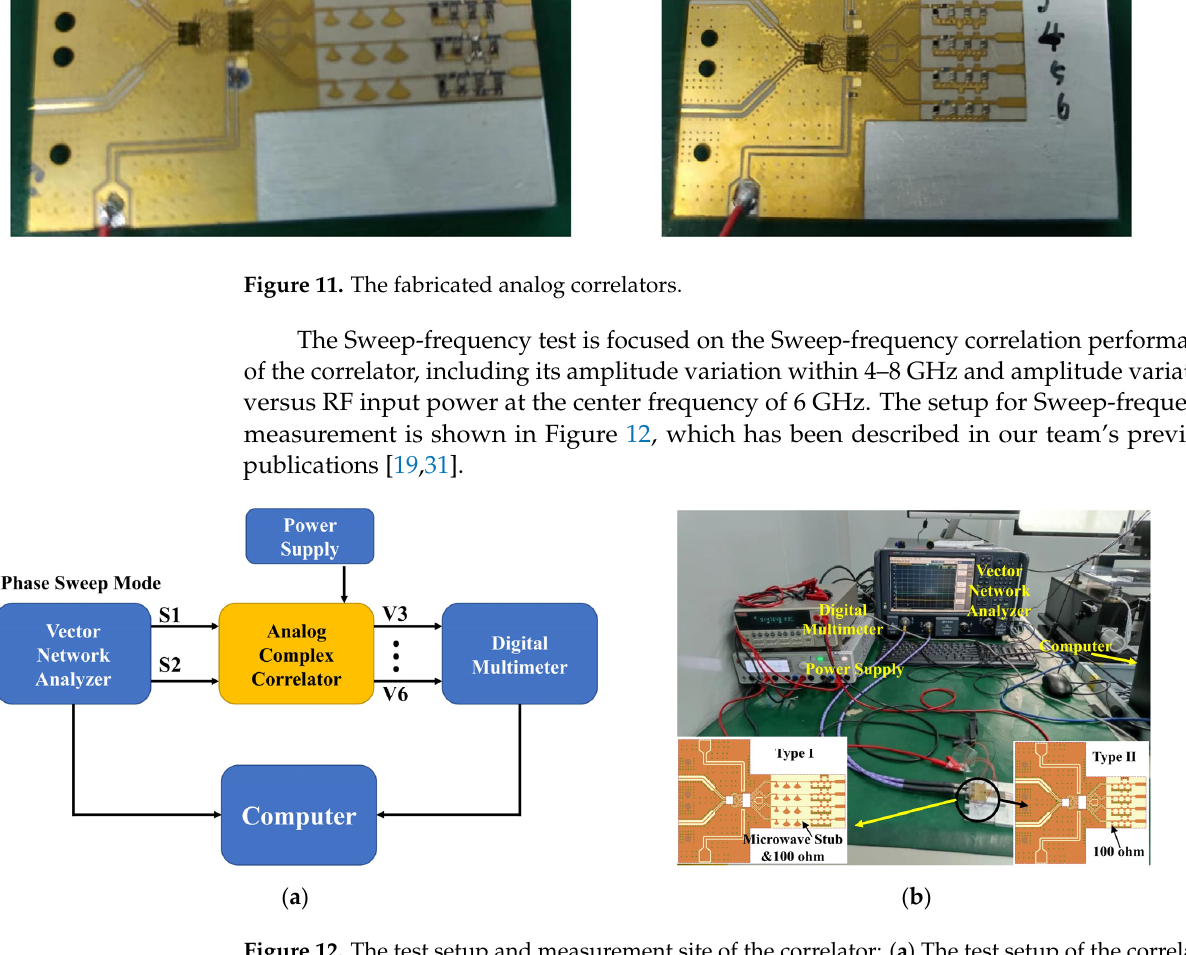
Figure 10. The measurement result of the six-port circuit: ( a ) Return loss of each port; ( b ) Gain of the integrated six-port circuit; ( c ) The amplitude imbalance of the six-port circuit; ( d ) The phase imbalance of the six-port circuit.